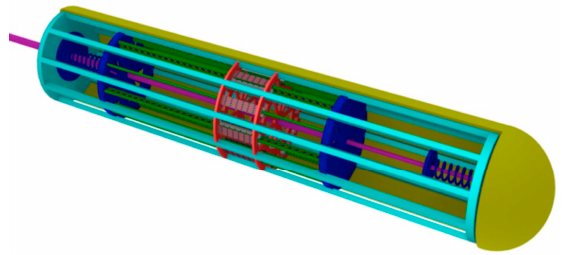
Figure 8. Cross section of the inner buoy of DEIM Point Absorber.